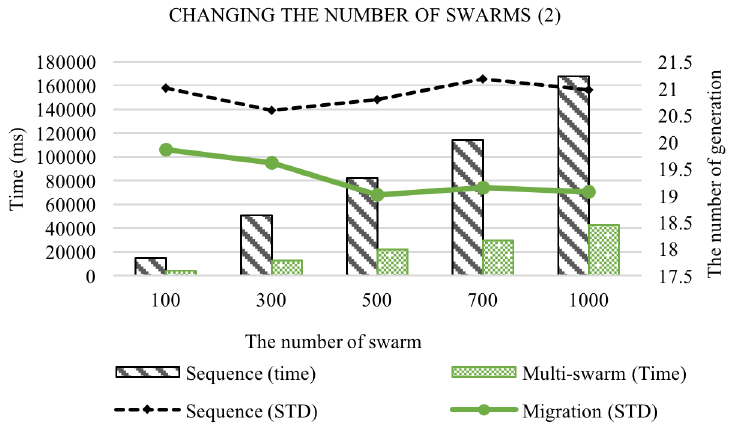
Fig. 1. Changing the number of swarms with parameters in Table 3, column (2).